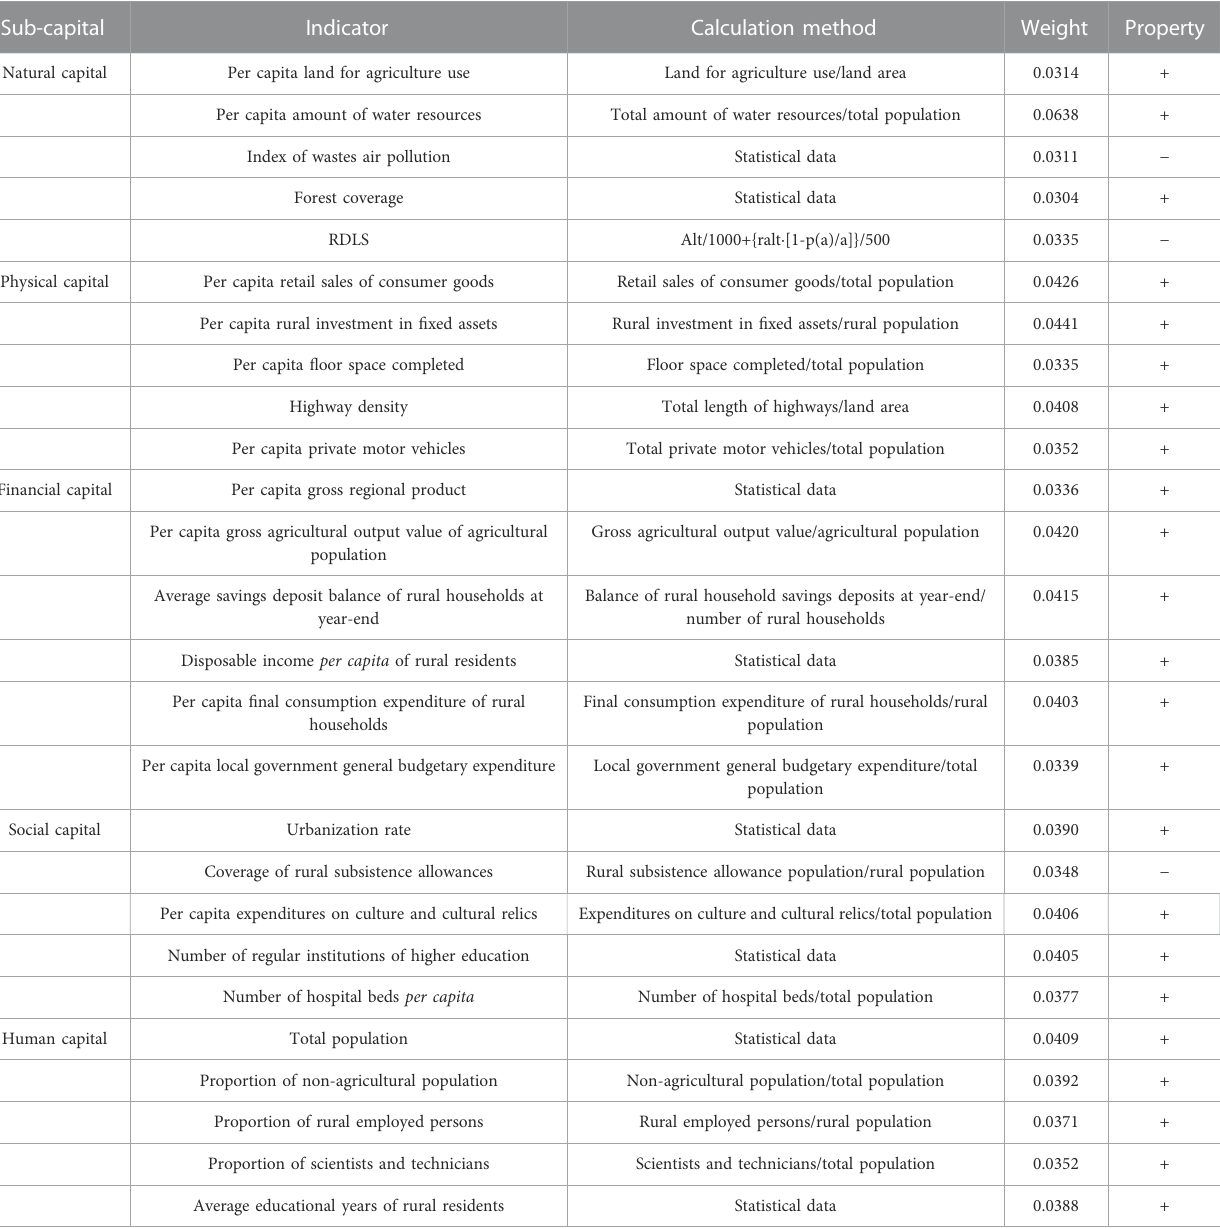
TABLE 2 Evaluation index system of regional livelihood